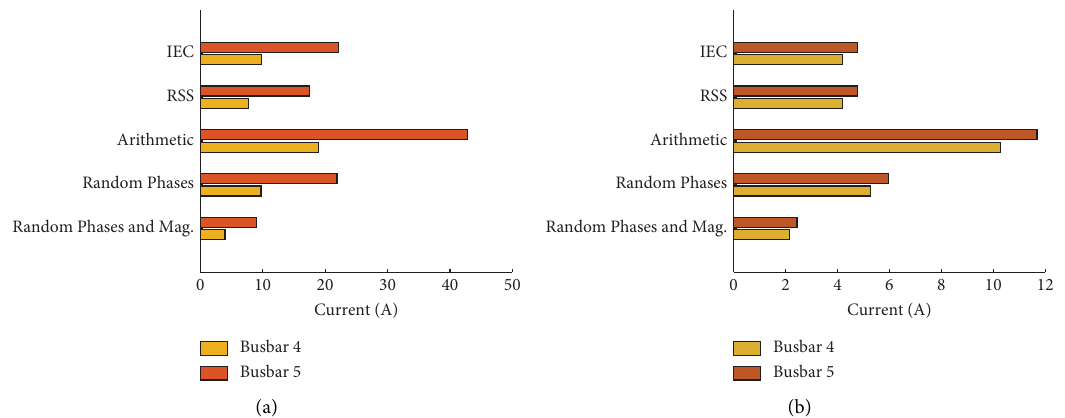
Figure 13: IEC results for 5th (a) and 13th (b) harmonic for Case 2.